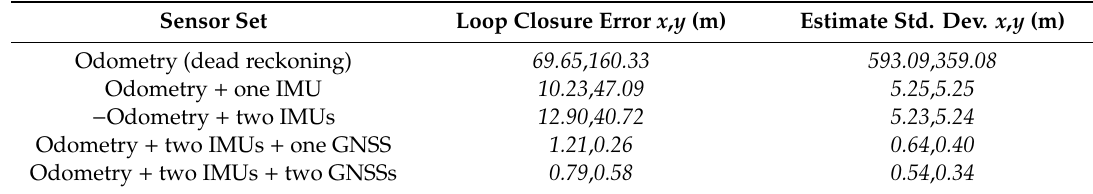
Table 1. Errors for five di ff erence sensor configurations